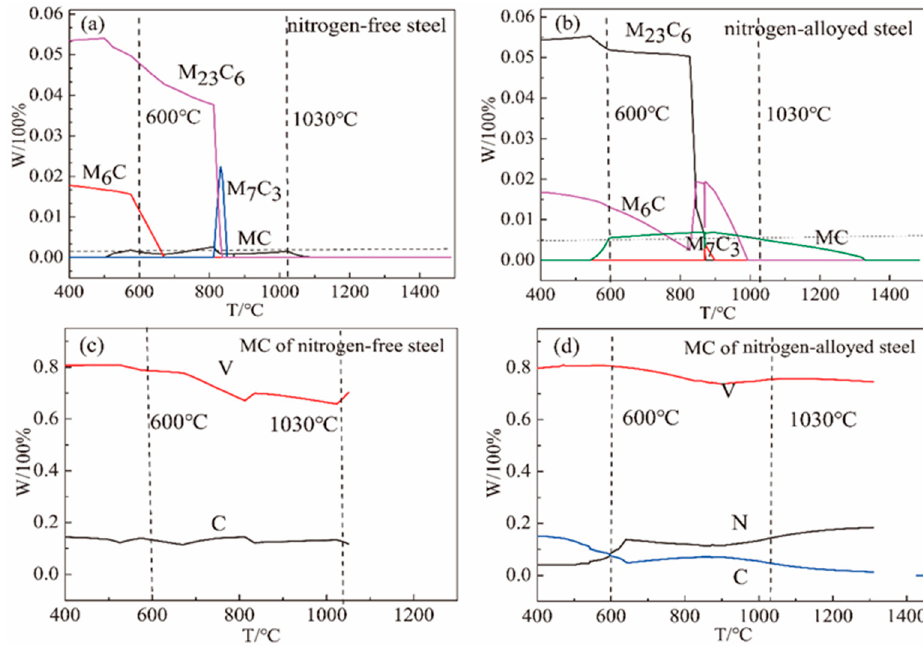
Figure 7. Equilibrium precipitation calculated by Thermo-Calc software for various carbides in samples (W: Weight percent in y axis): ( a ) Nitrogen-free; and ( b ) nitrogen-alloyed steel; and for the elements of the MC carbide ( c ) nitrogen-free; ( d ) nitrogen-alloyed steel.